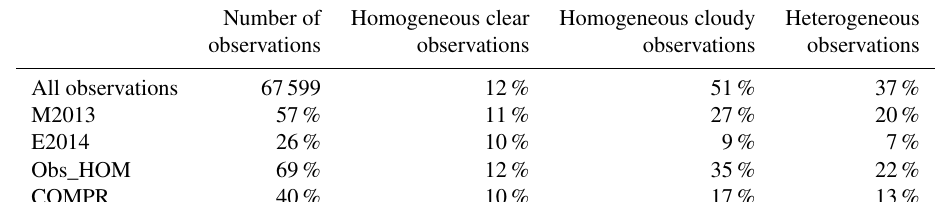
Table 2. Evaluation of heterogeneity inside the IASI pixel with respect to the SEVIRI cloud type.